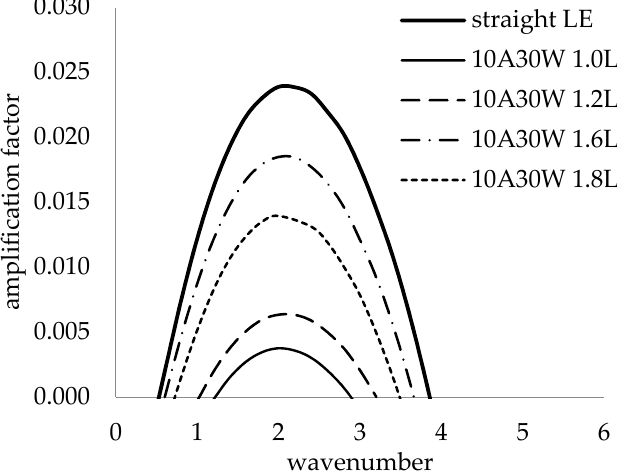
Figure 22. Amplification curves at different span locations for 10A30W and straight LE at 0.124 chord fraction.